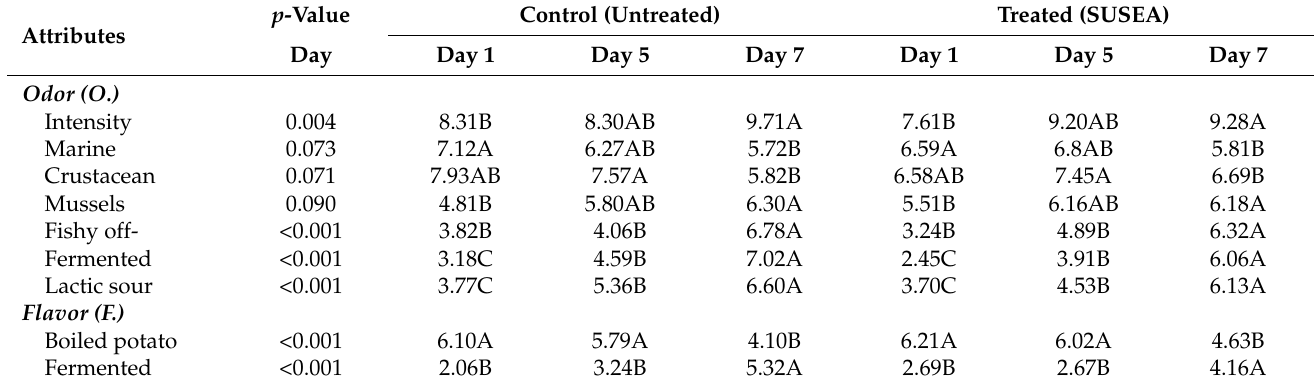
Table 4. Mean intensities (150 mm scale) of attributes varying with storage Day ( p < 0.1), according to the factorial 2-way ANOVA model (fixed factors: Treatment, Day, Interaction: Treatment*Day). Post hoc, Fischer LSD, capital letters indicate significant differences between storage days.